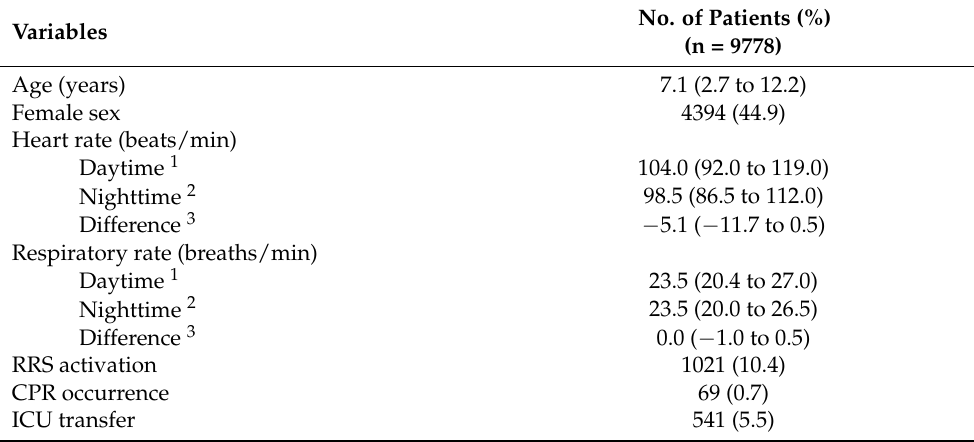
Table 1. Baseline characteristics of the study